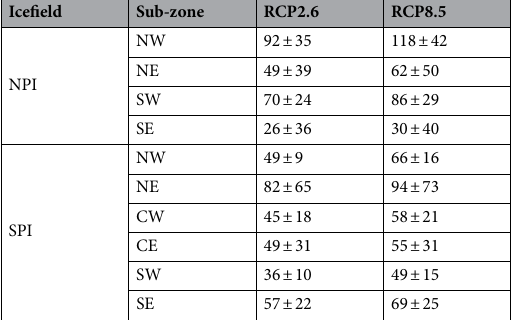
Table 2. Range of difference in the mean long-term ELA per sub-zone between historical period and each RCP scenario. ELA was obtained as the long-term mean of the elevation where the SMB reached 0 m w.e. The range of difference at each scenario is given by the runs using − 1 °C and − 3 °C of cooling effect as meteorological observations suggests 18 as well as the uncertainty given by the different methods used to the partitioning between rain and snow 19 .